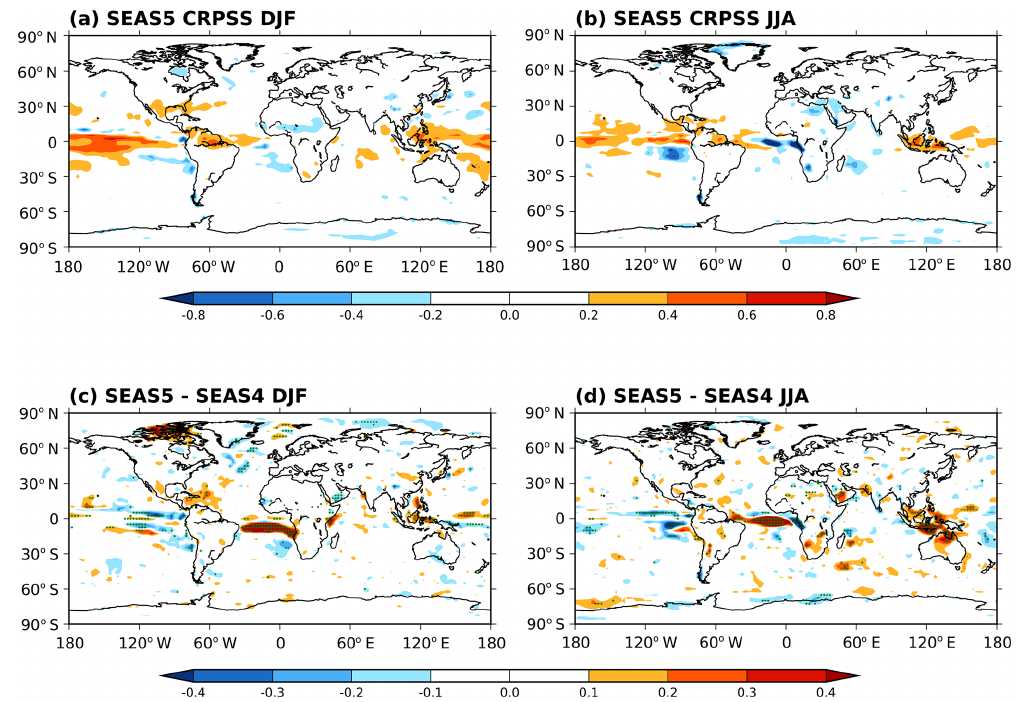
Figure 22. (a, b) CRPSS maps of precipitation for SEAS5 with reference to GPCP climatology (1981–2014) in (a) DJF and (b) JJA. (c, d) The change in precipitation CRPSS score between SEAS5 and SEAS4 in (c) DJF and (d) JJA. Green stippling is plotted at p < 0 . 05.